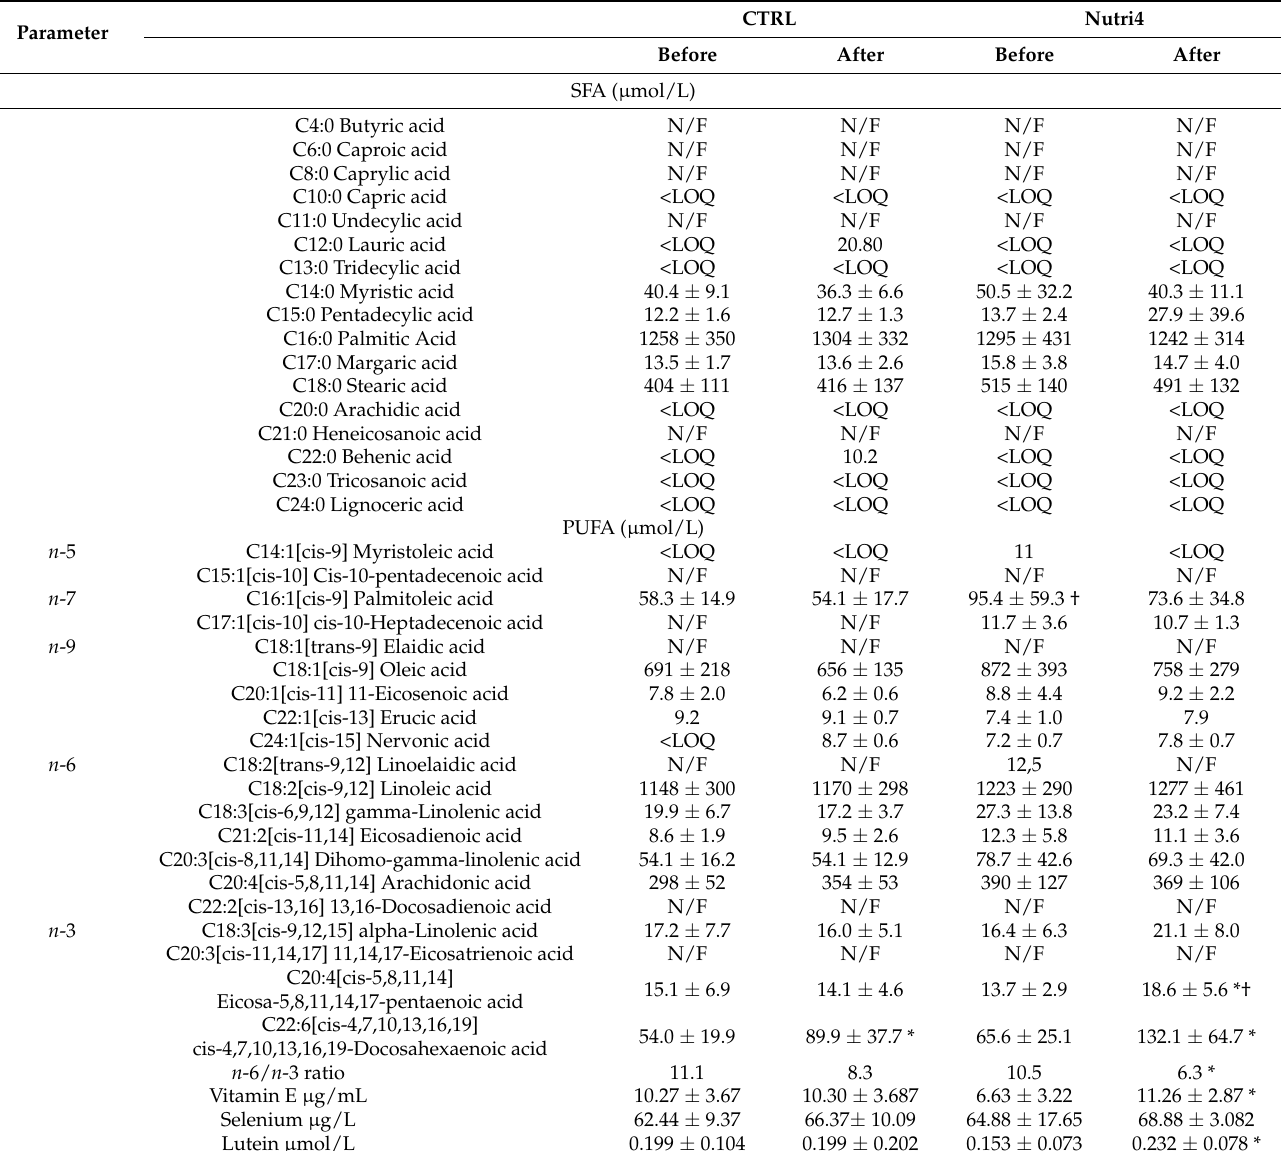
Table 3. The Effect of Regular and Nutri4 Hen Eggs Consumption on Serum Fatty Acids Profile, Vitamin E, Selenium and Lutein in Healthy